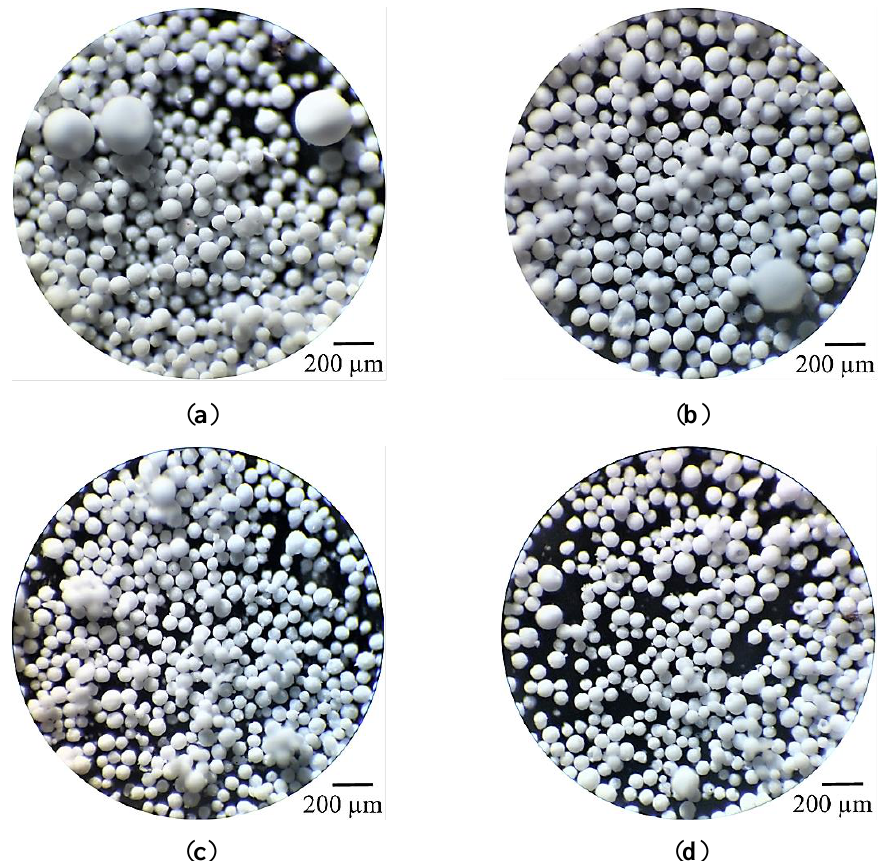
Figure 4. Effect of the W concentration on the BET area of the 25SA‒WO x samples calcined at ( a ) 550 °C, ( b ) 650 °C, ( c ) 750 °C and ( d ) 950 °C.